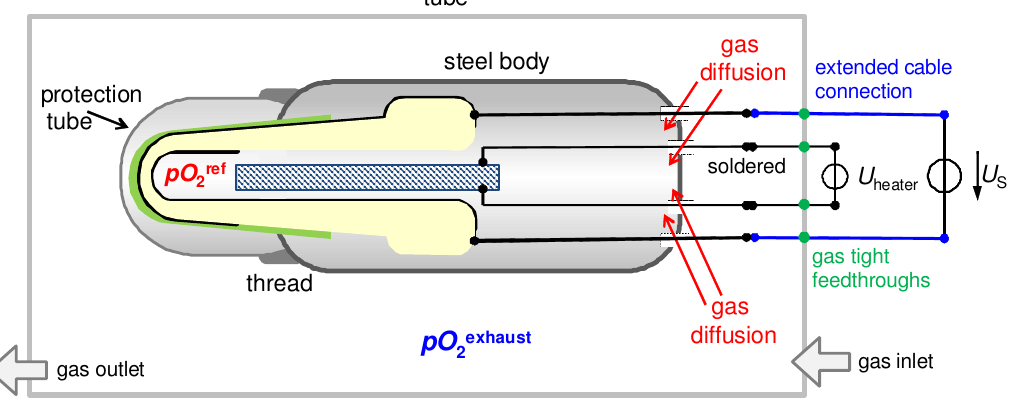
Figure 2. Setup to investigate the sensor response with changing reference atmosphere by gas